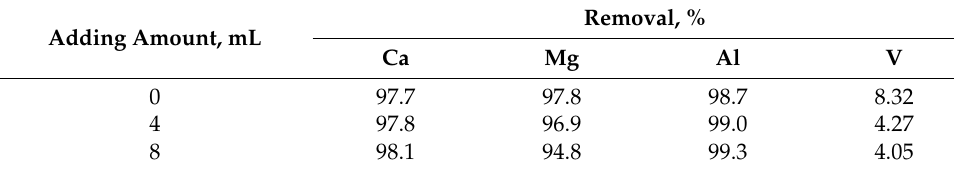
Table 4. Effect of flocculant on the purification